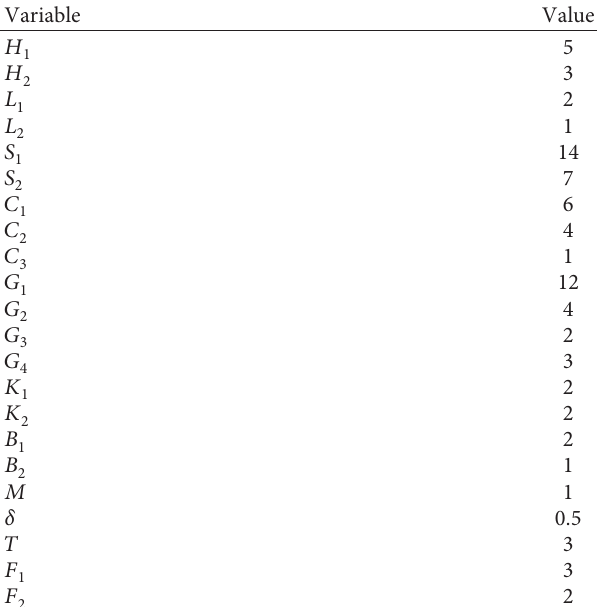
Table 2: Data of